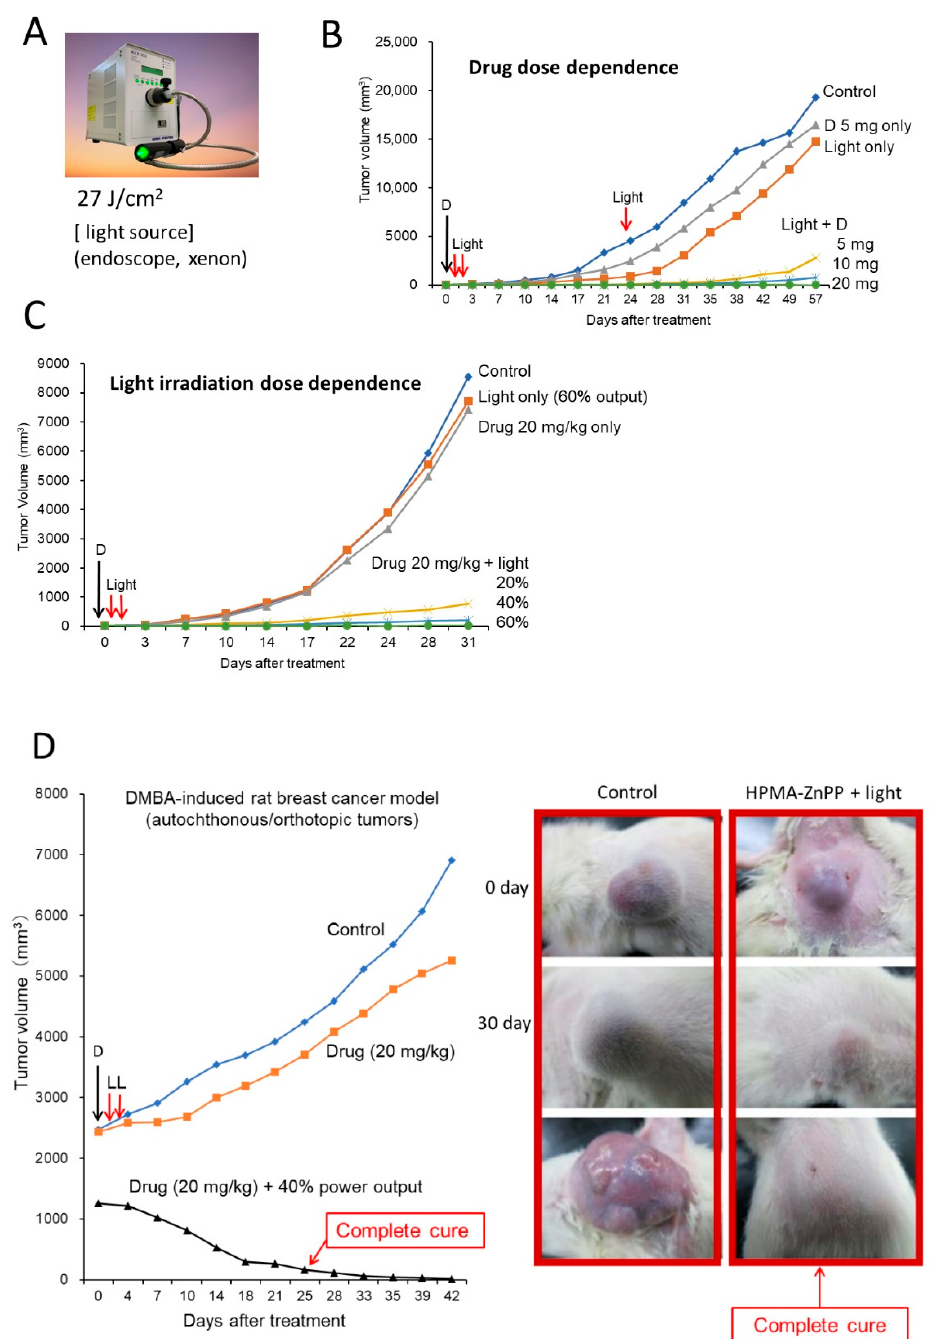
Figure 5. Photodynamic therapy (PDT) with polymeric PSs. ( A ) View of the light source for the endoscope; a xenon lamp was used. ( B ) Dose dependence of P-ZnPP dosage, marked D. ( C ) Dose of light irradiation intensity. The D indicates the time of drug injection of P-ZnPP in B and C. The power of irradiation light (%) is relative to full power output of the endoscope (100%). ( D ) Results of PDT treatment of DMBA-induced breast cancer in rats. L, light irradiation. D, drug injection. Control received only light. Boxed images at right show growth and suppression of tumor after PDT and P-ZnPP treatment ( right ) and tumor without treatment ( left ).